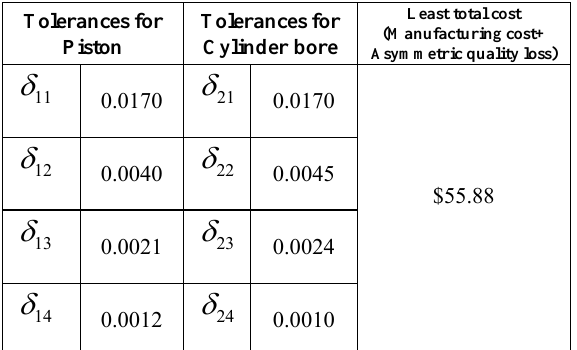
Table 2 Optimal tolerances allocated using genetic algorithm – Worst case